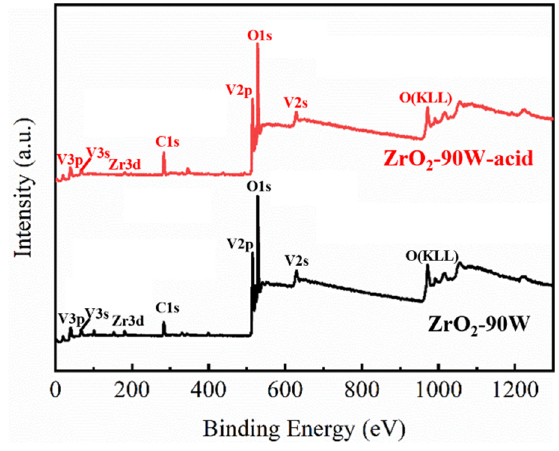
Figure 6. XPS survey spectrum of samples ZrO 2 -90 W and ZrO 2 -90 W-acid. As seen in Figure 7a,b, the peak of Zr 3d could be fitted into Zr 3d 5/2 and Zr 3d 3/2 , located at 182.1 eV and 184.5 eV, respectively, corresponding to Zr 4+ . After the acid-solution process, the peaks of Zr 3d 5/2 and Zr 3d 3/2 were located at 182.2 eV and 184.6 eV, respectively, which also corresponded to Zr 4+ in ZrO 2 , and the intensity of the peak was almost unchanged, indicating that the Zr content was nearly unchanged after the acid-solution process. This is probably due to the excellent chemical stability ZrO 2 displayed in acidic solutions. After the acid-solution process, only a small amount of Zr element was probably reacted. This is confirmed by the XPS result in Figure 6. The results shows that the molar ratio of Zr/V increased from 0.02 to 0.05 during the acid-solution process, indicating that V was lost from the film at a faster rate than Zr. The 20 s of the acid-solution process did not entirely remove Zr [39]. If extending the processing time, the solar-modulation rate of the films would decrease significantly. The characteristic peak of V in the sample before the acid-solution process had two peaks corresponding to V 2p 1/2 and V 2p 3/2 , as shown in Figure 7c. For V 2p 3/2 , there were two binding energy peaks located at 516.2 eV and 517.5 eV that could be assigned to +4 and +5 valences of V, respectively [5,40,41]. The primary source of V’s +5 valence was V 2 O 5 , indicating that the film surface was partly oxidized. O 1s spectra could be fitted into two peaks. The peak at ~530 eV was attributed to the V-O bond in the crystal lattice, whereas the peak at ~532 eV belonged to the surface-chemisorbed oxygen species [30,31]. After the acid-solution process, the film’s peak position was barely altered, whereas the content of the chemisorbed oxygen species was decreased, indicating that the island-like ZrO 2 -VO 2 composite film exhibited good oxygen resistance, different from previous works [38]. The resistance was recorded at gradient temperatures ranging from 20 ◦ C to 90 ◦ C in order to determine the phase-transition temperature ( T c ) of samples ZrO 2 -90 W and ZrO 2 -90 W-acid. Figure 8 depicts the electrical hysteresis loop of the film. After the introduction of ZrO 2 to the film, it can be seen that the T c of the film increased to 52 ◦ C, which may be attributed to the interfacial stresses caused by the ZrO 2 and VO 2 grains. Additionally, the electrical hysteresis loop’s breadth was about 8 ◦ C. After the acid-solution process, some channels or voids were generated in the film and the stress between the crystal grains was released; hence, the T c of the film rose to 58 ◦ C and the width of the electrical hysteresis loop was expanded to 12 ◦ C, which can be mainly attributed to the hysteresis effect in the thermal transmission process caused by the channels or voids between the grains